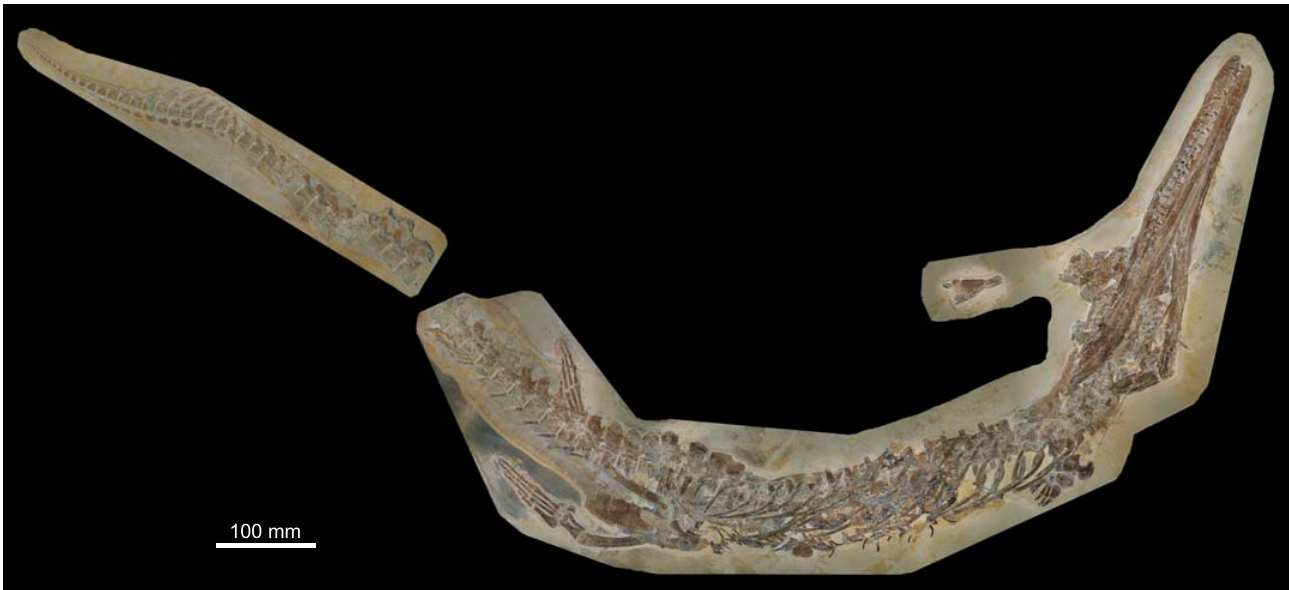
Fig. 1. Metriorhynchid thalattosuchian Cricosaurus bambergensis sp. nov., NKMB-P-Watt14/274, holotype, late Kimmeridgian of Wattendorf (southern Germany). Skeleton in ventrolateral